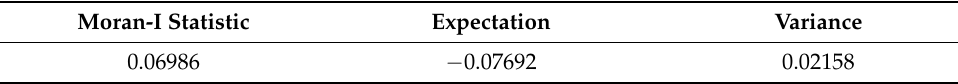
Table 7. Moran’s I test sample estimates of spatial